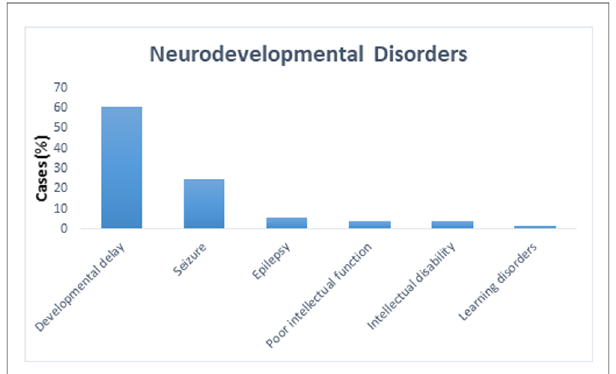
FIGURE 2 The percentage of different neurodevelopmental disorders among all 105 cases. Developmental delay was the most frequently observed formed 60%, while 5% of patients had epilepsy, 4% had intellectual disability, and 1% had learning